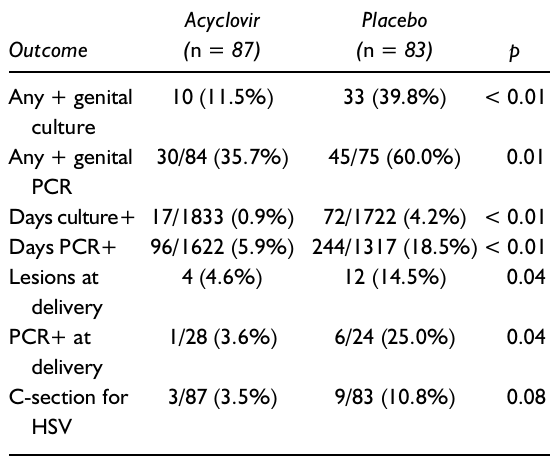
Table 1 Efficacy of acyclovir for the treatment of genital herpes simplex virus (HSV)